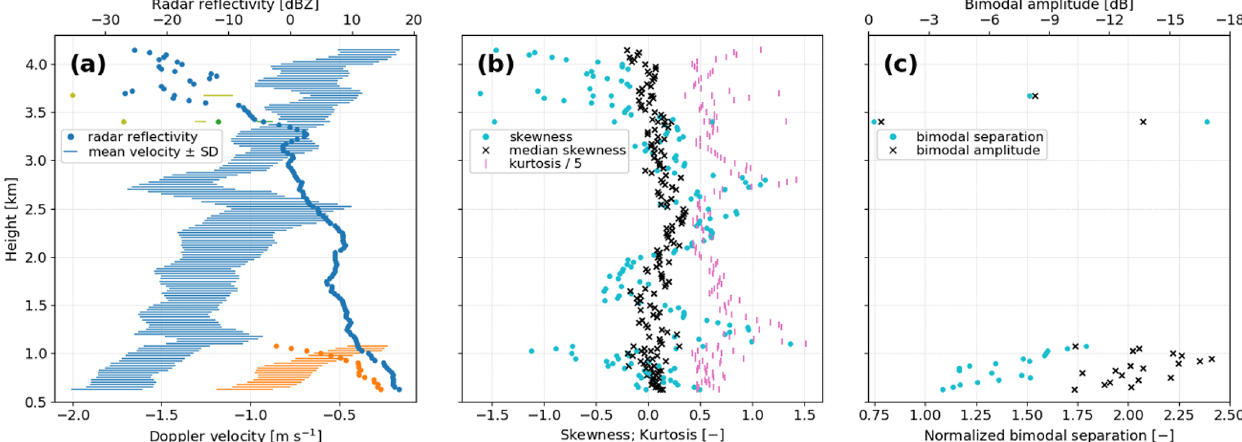
Figure 6. Summary of (a, b) modal and (c) multimodal properties calculated for all Doppler spectra that form the weather signal shown in Fig. 5a. Different colors in panel (a) indicate different precipitation modes that are identified following the methodology presented in Sect. 2.3; in panels (b) and (c) , different modes are not marked by different colors.